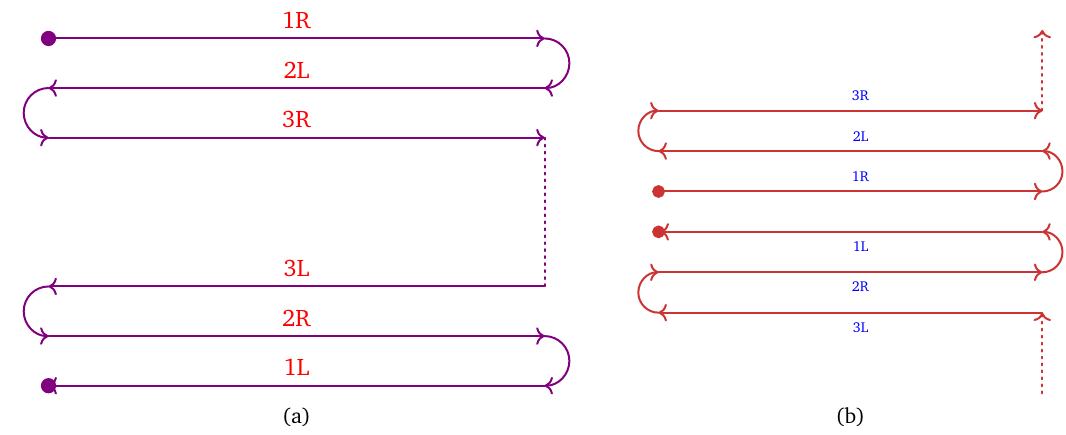
Figure 2: The k-OTO contour computing the out-of-time-ordered correlation func- tions encoded in the generating functional (4). (a) The contour drawn makes explicit the notion of depth ; the segments with are nested inwards in order of increasing depth which is equivalent to the distance from the density matrix. (b) An alternate way of drawing the contour as e.g., used in [ 8 ] with contours of increasing depth going out- wards from a central region. The second can be obtained from the first by turning the switchbacks